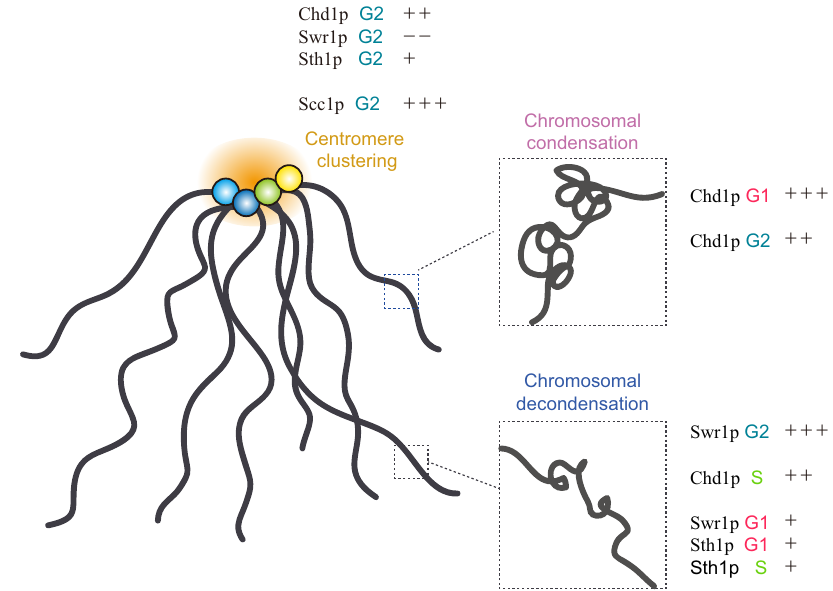
Fig. 5 The regulatory functions of chromatin remodelers and cohesin in the Rabl con fi guration. The schematic model summarizes the distinct roles of chromatin remodelers (Chd1p, Swr1p, and Sth1p) and cohesin (Scc1p) in 3D genome organization. We classi fi ed their roles based on the following three processes: (1) (intra) chromosomal condensation (pink); (2) (intra) chromosomal decondensation, (blue); and (3) centromere clustering (yellow). The degree of impact was expressed as a number of ‘ + ‘ (positive effect) or ‘ − ‘ (negative effect) symbols. Each cell cycle stage is marked with a different color (G 1 , red; S, yellow green; G 2 , teal